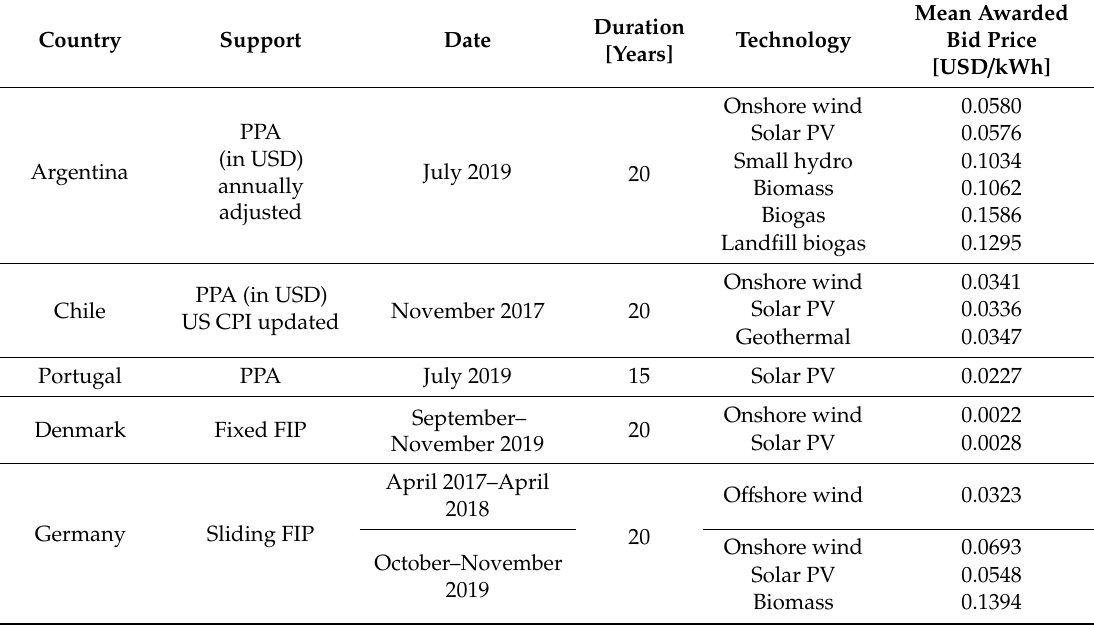
Table 1. Data of renewable energy sources (RES) auctions held in the 2017–2019 period in selected countries. Source: Self-elaboration based on